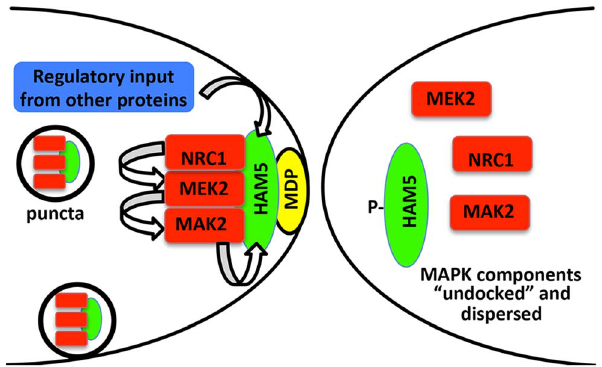
Figure 8. Model for HAM-5-MAK-2/MEK-2/NRC-1 function during chemotropic interactions. HAM-5 interacts with MAK-2, MEK-2 and NRC-1 and assembles in puncta throughout the germling, some of which are recruited to the CAT tip during chemotropic interactions via interactions with a plasma membrane associated protein (MDP: membrane docking protein). Association of the HAM-5/ MAK-2/MEK-2/NRC-1 complex to the CAT tips is associated with signal reception from the partner germling. During this process, HAM-5 is successively phosphorylated by MAK-2 and other kinases, resulting in the disassociation of the complex and termination of the ability to receive signal. Nuclear MAK-2 signaling to the transcription factor PP-1 is not believed to be essential for chemotropic interactions as treatment of germlings with cycloheximide did not disturb oscillation of MAK-2 nor chemotropic behavior [19]. The coordinated assembly and disassembly of HAM-5/MAK-2/MEK-2/NRC-1 during communication regulates the tempo of chemotropic interactions between